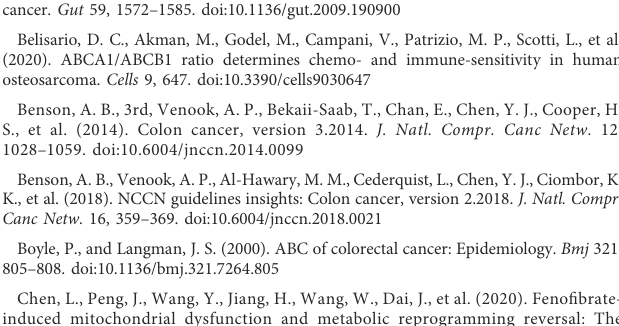
SUPPLEMENTARY FIGURE S1 Ezetimibe suppresses the Caco2 cell migration in low doses. (A) The wound healing capacity for Caco2 under gradient ezetimibe treatment at 0, 24, and 48 h. Scale bar, 100 μ M. (B) Statistical analysis for the wound area of Caco2 under gradient ezetimibe treatment at 0, 24 and 48 h. * p < 0.05, *** p < 0.001. SUPPLEMENTARY FIGURE S2 Ezetimibe downregulates the MMP2, MMP9 and Bcl-2, companied with caspase-8, caspased-9 activation. (A) Protein expression of MMP-2, MMP-9, Bcl-2, caspase-8, caspase-9 and β -actin in HCT116 and Caco2 cells under gradient ezetimibe treatment. (B) Statistical analysis for the protein expression level of MMP-2/ β -actin, MMP-9/ β -actin, Bcl-2/ β -actin, cleaved